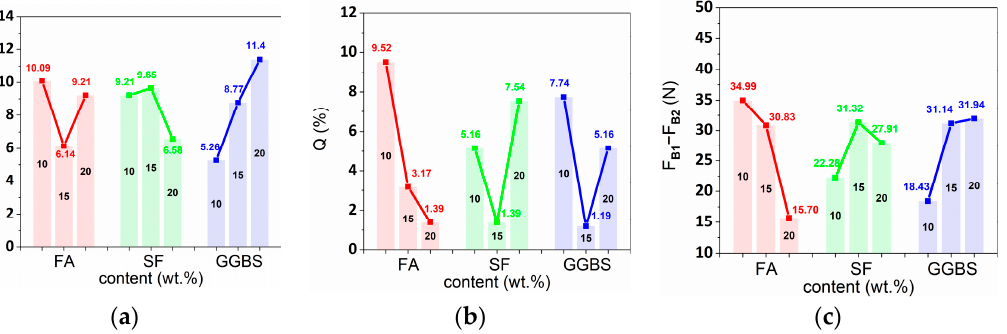
Figure 11. The J ( a ), Q ( b ), and F B1 − F B2 ( c ) average values with the various content (10%, 15%, and 20%) of FA, SF, and GGBS, respectively. 20%) of FA, SF, and GGBS,